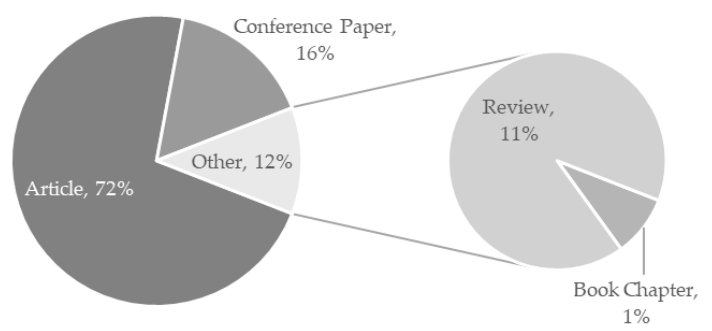
Figure 5. Categorization of studies based on the document type.